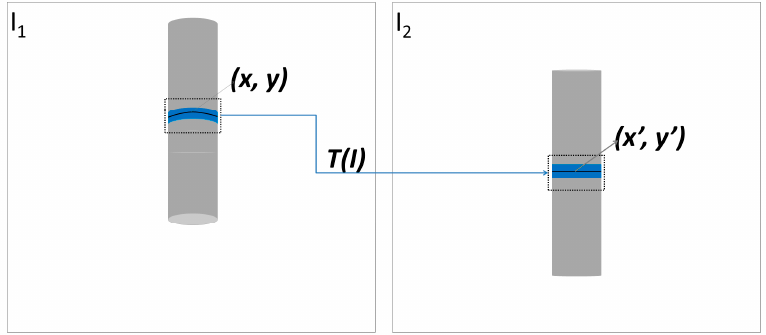
Figure 2. A geometric transformation function T is defined to map and approximate the corresponding points between image patches.